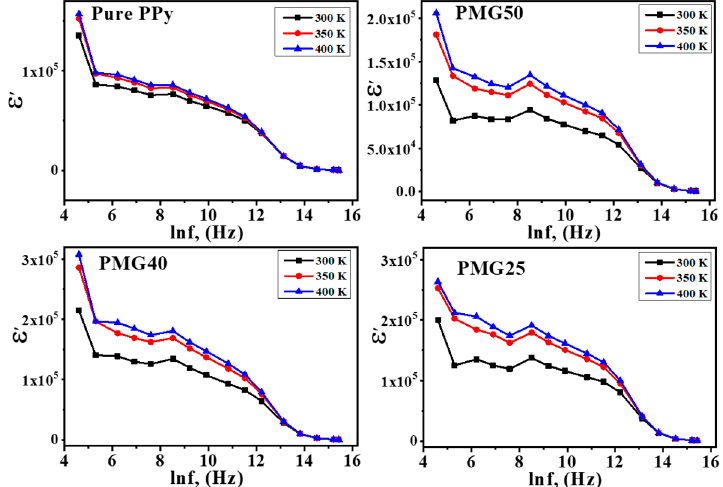
Figure 6. The dielectric constant ( ε ′ ) versus frequency at different temperatures for pure PPy and PMG composites with different ratios.